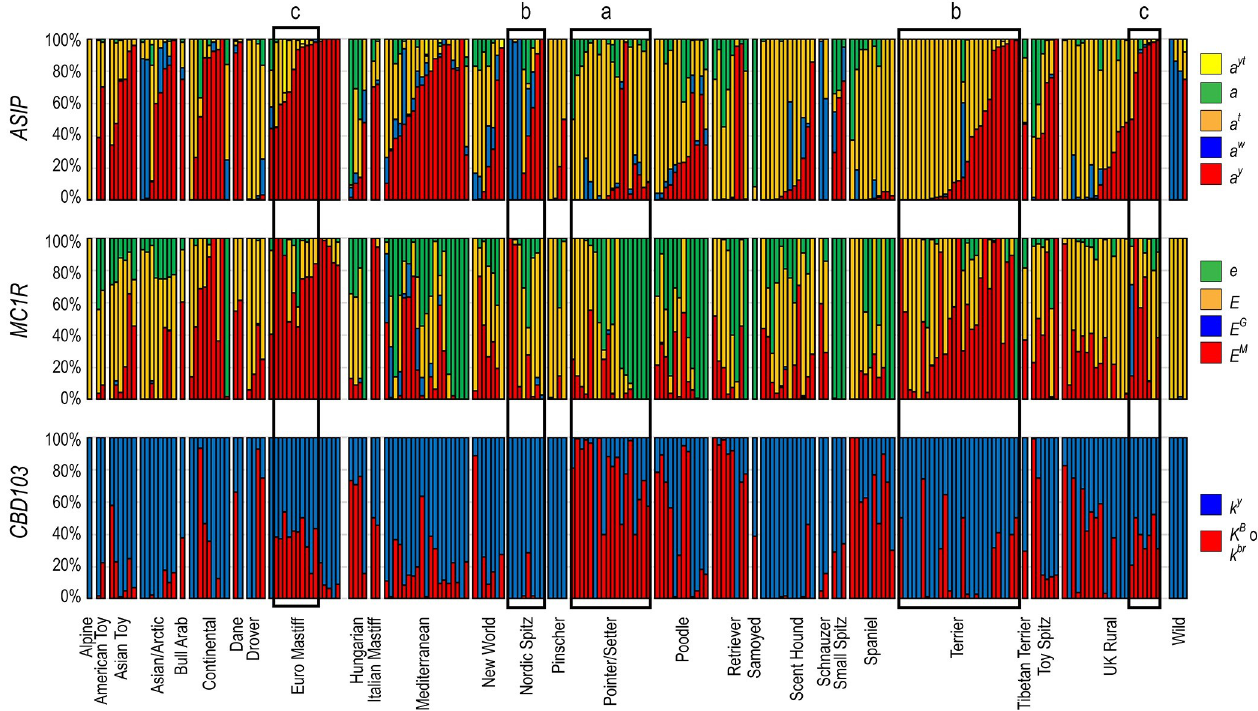
Fig 1. Allele frequencies for ASIP , MC1R , and CBD103 by phylogenetic breed relationship. Breeds are grouped by phylogenetic clade, as described, and sorted within clade by frequency of e and then a y to demonstrate patterns of phenotype expression across interacting genes. Thick black boxes highlight examples of color preference influencing interacting genes: a) Pointer/Setter breeds are commonly seen in solid colors, caused by the K B allele of CBD103 or the e / e genotype of MC1R . Since the solid-color genotypes are epistatic to the dominant alleles of MC1R and all alleles of ASIP , variation at those genes does not follow a trend for color preference. b) Related breeds with high frequency of the k y allele of CBD103 have a more structured pattern of ASIP allele preference. c) Breeds with a preference for the brindle pattern show heterogeneity for K B / k br (reflective of a k br phenotype) and high frequency of a y , required for the expression of brindle across the whole